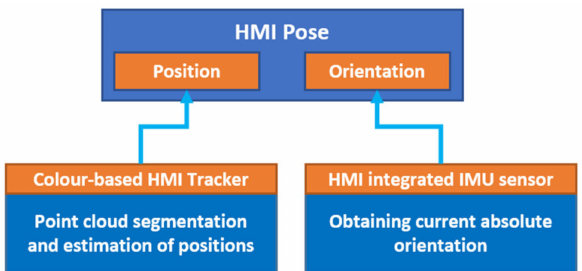
Figure 9. Determining HMI pose.